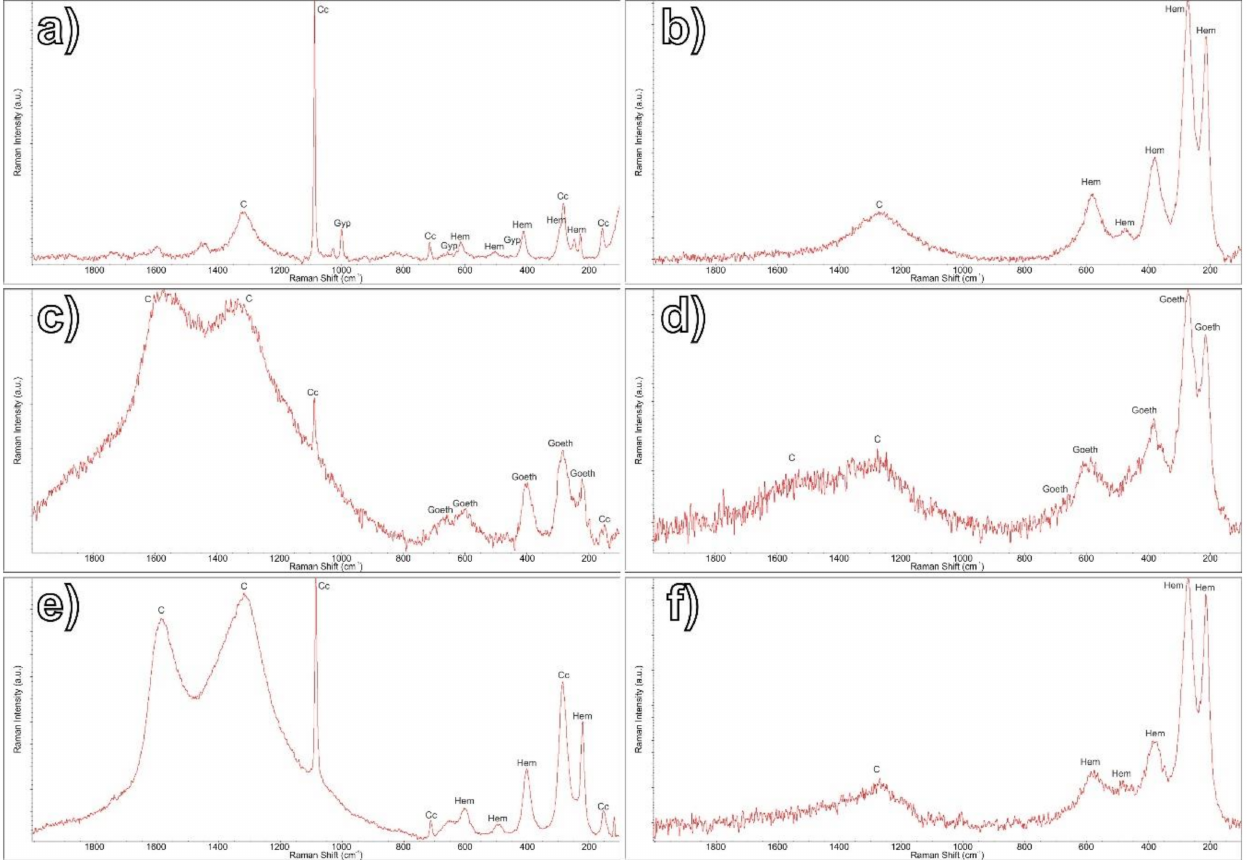
Figure 7. Representative Raman spectra of the Herculaneum samples and relative peaks identifications (compounds abbreviations: Cc = calcite, Gyp = gypsum, Hem = hematite, Goeth = goethite, and C = carbon). ( a ) BCN_28, pink-tinted plaster, matrix; ( b ) BCN_28, pink-tinted plaster, pigment lump; ( c ) BCN_28, yellow pictorial layer, matrix; ( d ) BCN_28, yellow pictorial layer, pigment lump; ( e ) BCN_59, red pictorial layer, matrix; ( f ) BCN_59, red pictorial layer, pigment